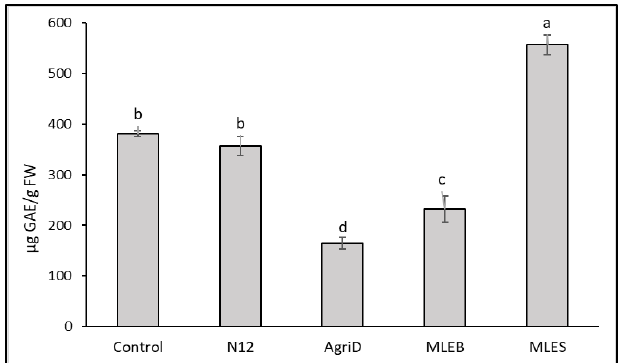
Figure 5. Effect of biostimulant application on total phenolic compounds (TPC) in lettuce leaves. Different letters indicate significant differences according to the Fisher ’s test ( p ≤ 0.05).